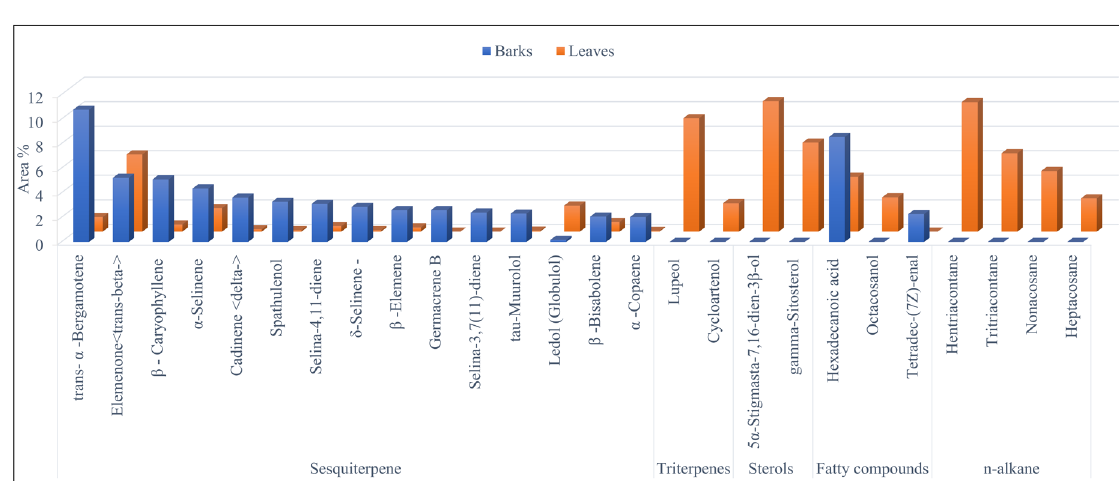
FIGURE 3 - Percentage area of the terpenes identified in the essential oil of barks and leaves from C. leptophloeos